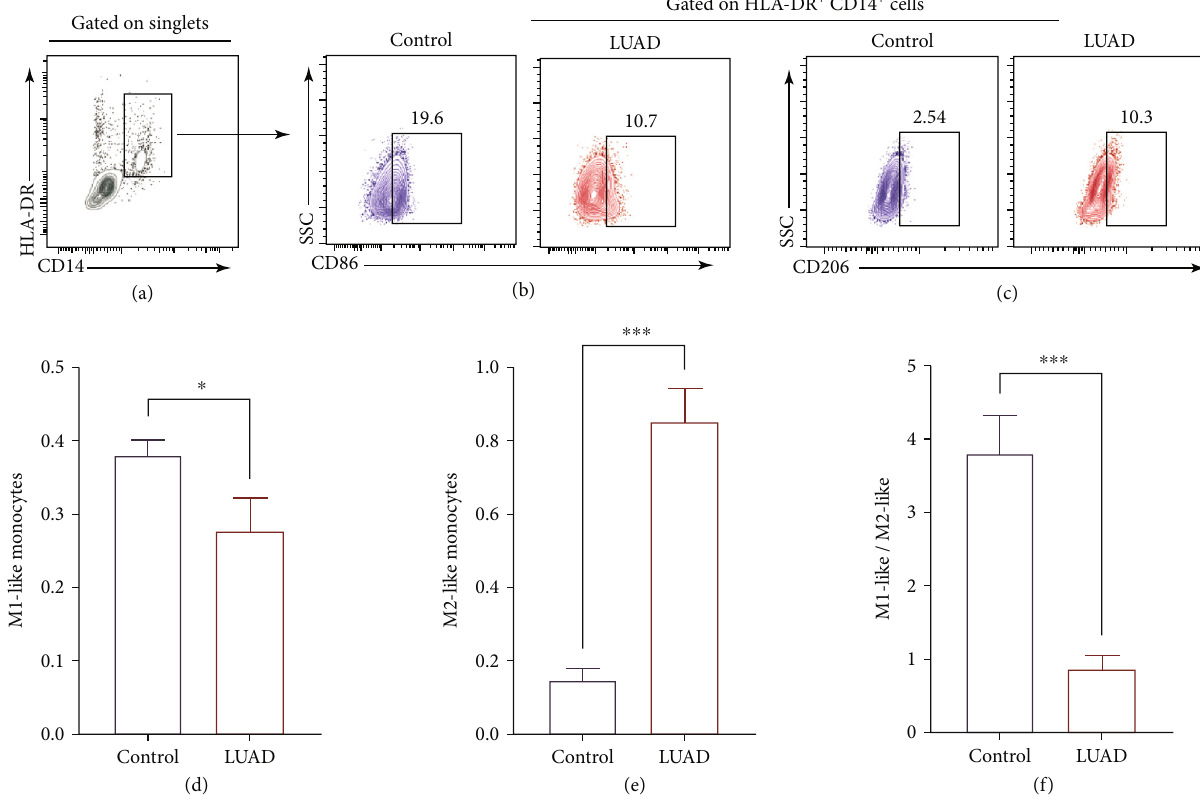
Figure 3: The immune balance of M1-like/M2-like monocytes was biased towards M2-like monocytes. (a) Gating strategy of CD14 + HLA- DR + cells. Gating strategy of M1-like monocytes (b) and M2-like monocytes (c) from patients and healthy controls. Frequency of M1-like monocytes (d) and M2-like monocytes (e) of blood samples from patients and healthy controls. (f) The ratios of M1-like monocytes/M2-like monocytes in blood samples from patients and healthy controls. Data shown were represented as mean ± SD (all samples were measured in triplicate). ∗∗∗ P < 0 : 001 , ∗ P < 0 : 05 ILC2 percentage (Figure 5(b), or the mRNA level of IL-13 (Figure 5(d)).